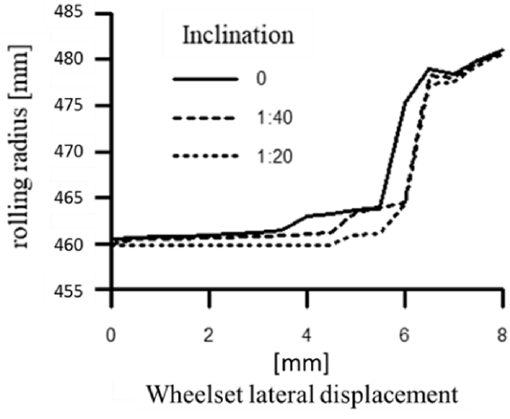
Figure 12. The tangent of the contact angle on the right side of the rail for various rail inclinations. The wheel rolling radius has analogous characteristic features as in the case of the tangent of the contact angle (Figure 13).